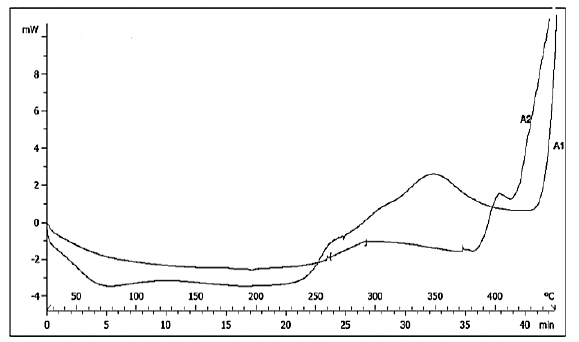
Figure 4. Differential scanning calorimetry of gum tragacanth and grafted gum tragacanth (A2)